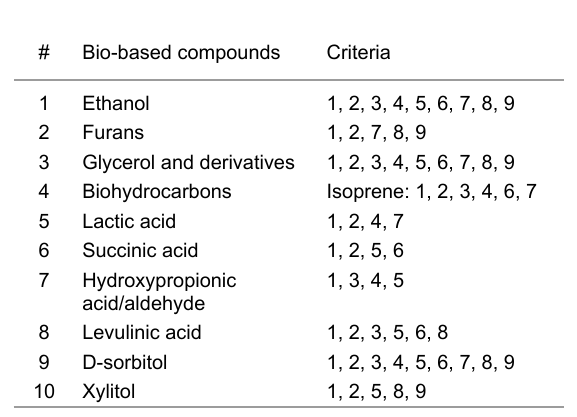
Table 1: Top chemical opportunities from biorefinery carbohydrates and criteria of selection.